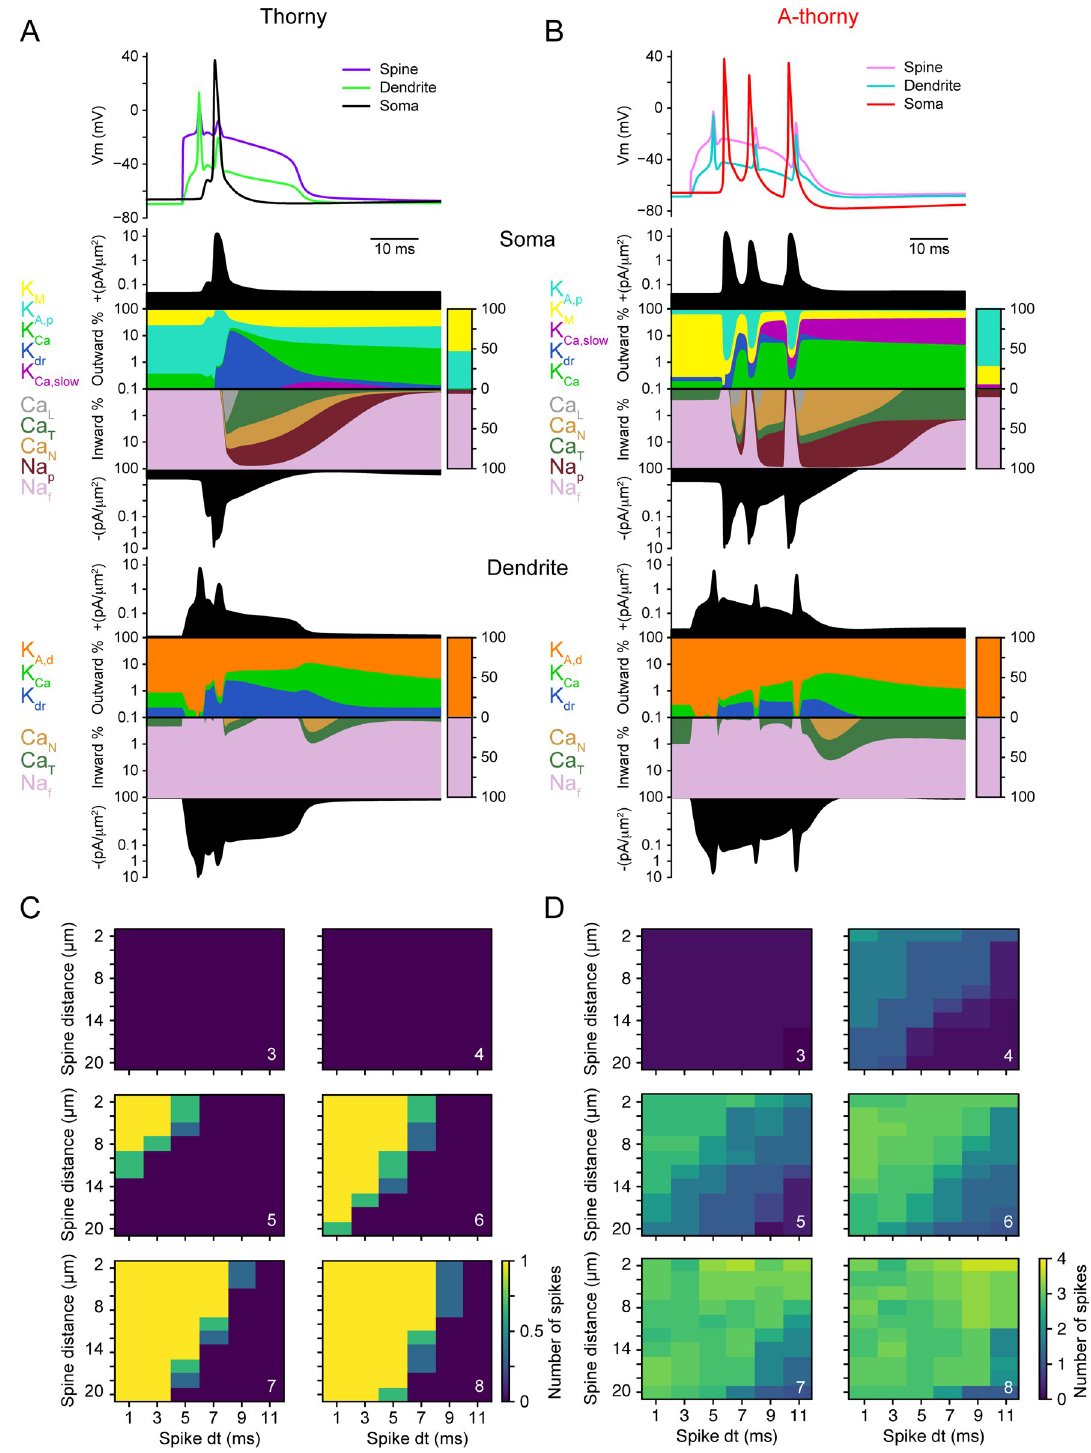
Fig 6. Distinct responses of thorny and a-thorny cells to clustered dendritic inputs. (A) Top, simulated Vm dynamics in a thorny cell in response to the concomitant arrival of 6 presynaptic inputs. The spine and dendrite Vm clearly show the dendritic plateau that lies at the origin of the AP that is then propagated at the soma. Middle and bottom, visualizations of the dynamics of inward and outward ionic currents (i.e., “currentscapes”) respectively at the soma and at the dendritic location where the stimulated spine is connected. In each currentscape, the filled black areas represent the total amount of outward and inward current densities (top and